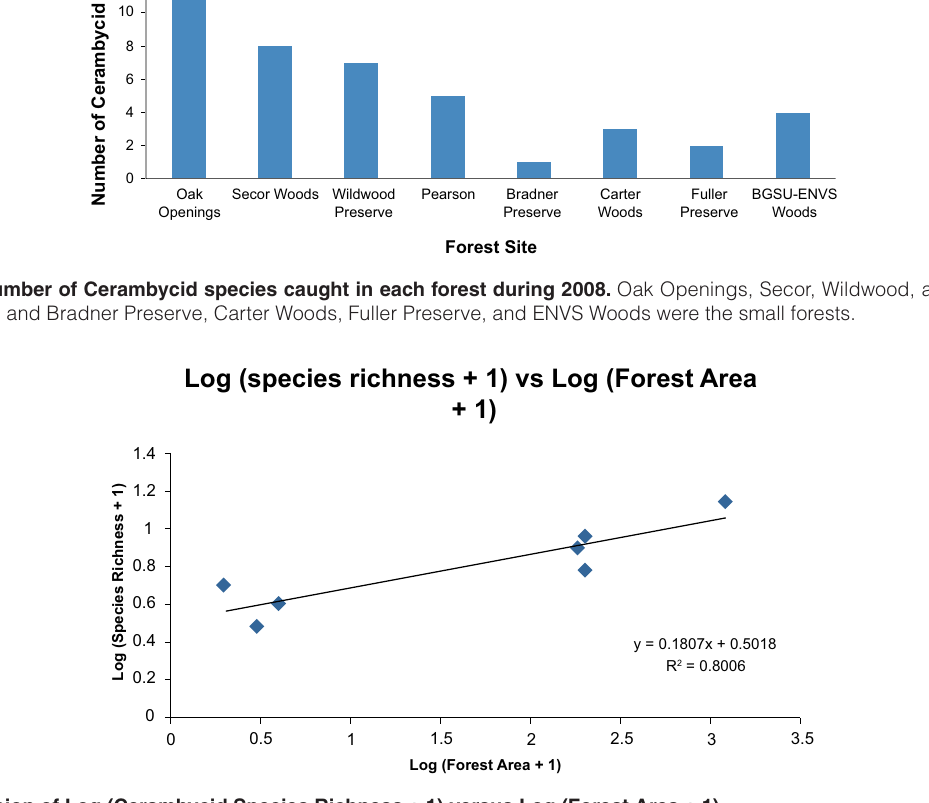
Figure 7. Regression of Log (Cerambycid Species Richness + 1) versus Log (Forest Area +